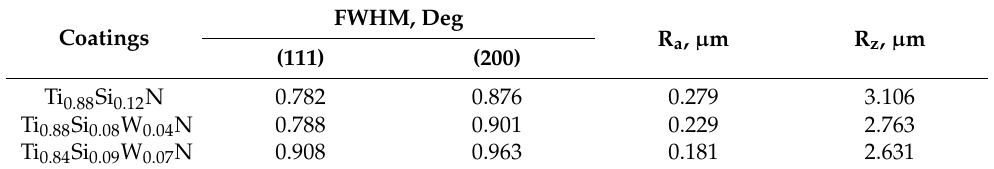
Figure 1. XRD diffractograms of as-deposited Ti 0.88 Si 0.12 N, Ti 0.88 Si 0.08 W 0.04 N, and Ti 0.84 Si 0.09 W 0.07 N powdered coatings. Table 1. The determination results of FWHM and surface roughness (R a and R z ) for each coating.